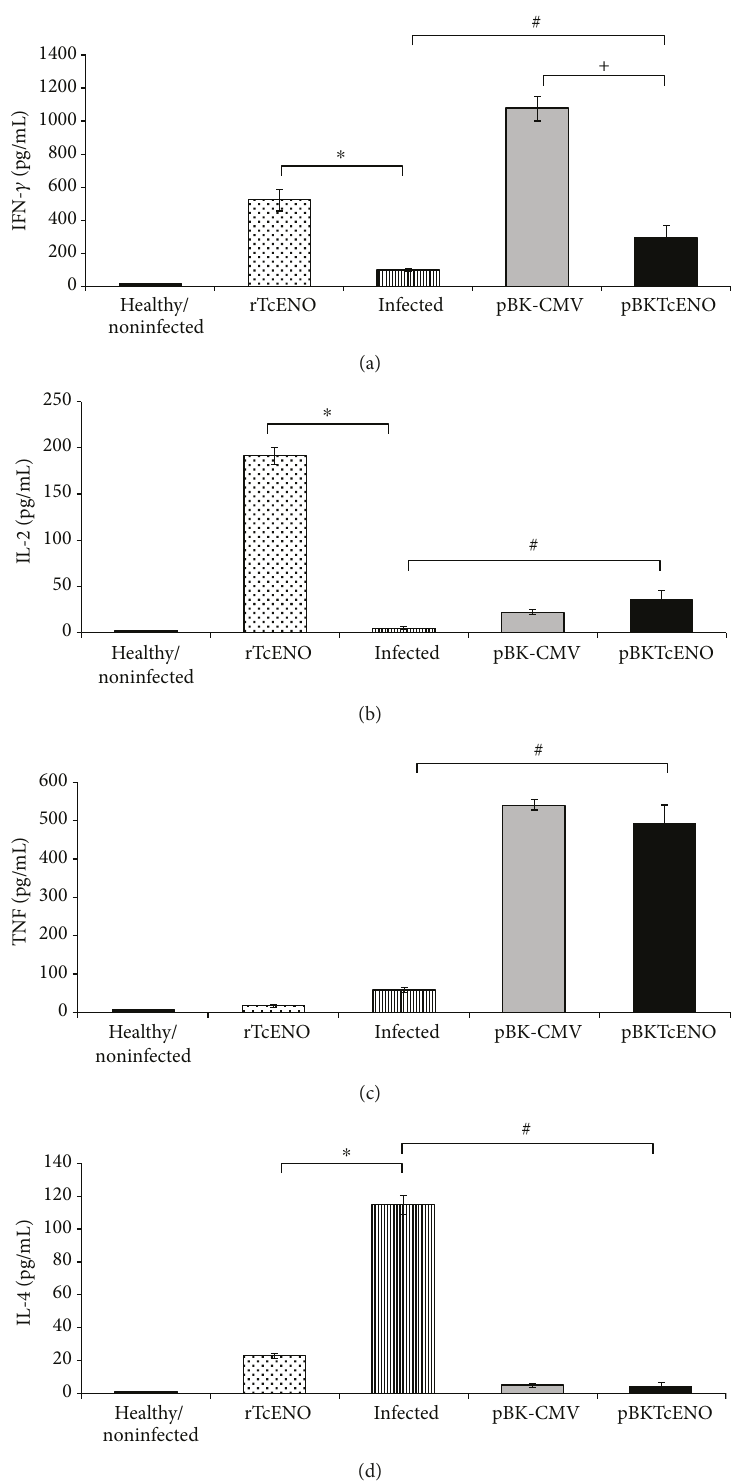
Figure 5: Serum cytokine levels in immunized and nonimmunized mice after challenge. Serum levels of (a) IFN- γ , (b) IL-2, (c) TNF, and (d) IL-4 were determined by fl ow cytometry. The concentration of a particular cytokine was established by comparing the obtained data with a standard curve for each experiment. The data are represented as the mean ± SD. All measurements were performed in duplicate, with serum from eight mice per group. Sera from healthy mice (noninfected and nonimmunized) were used as controls. Signi fi cant di ff erences were detected as follows: rTcENO versus infected ( ∗ p < 0 01 ), pBKTcENO versus infected ( # p < 0 01 ), and pBKTcENO versus pBK-CMV ( + p < 0 01